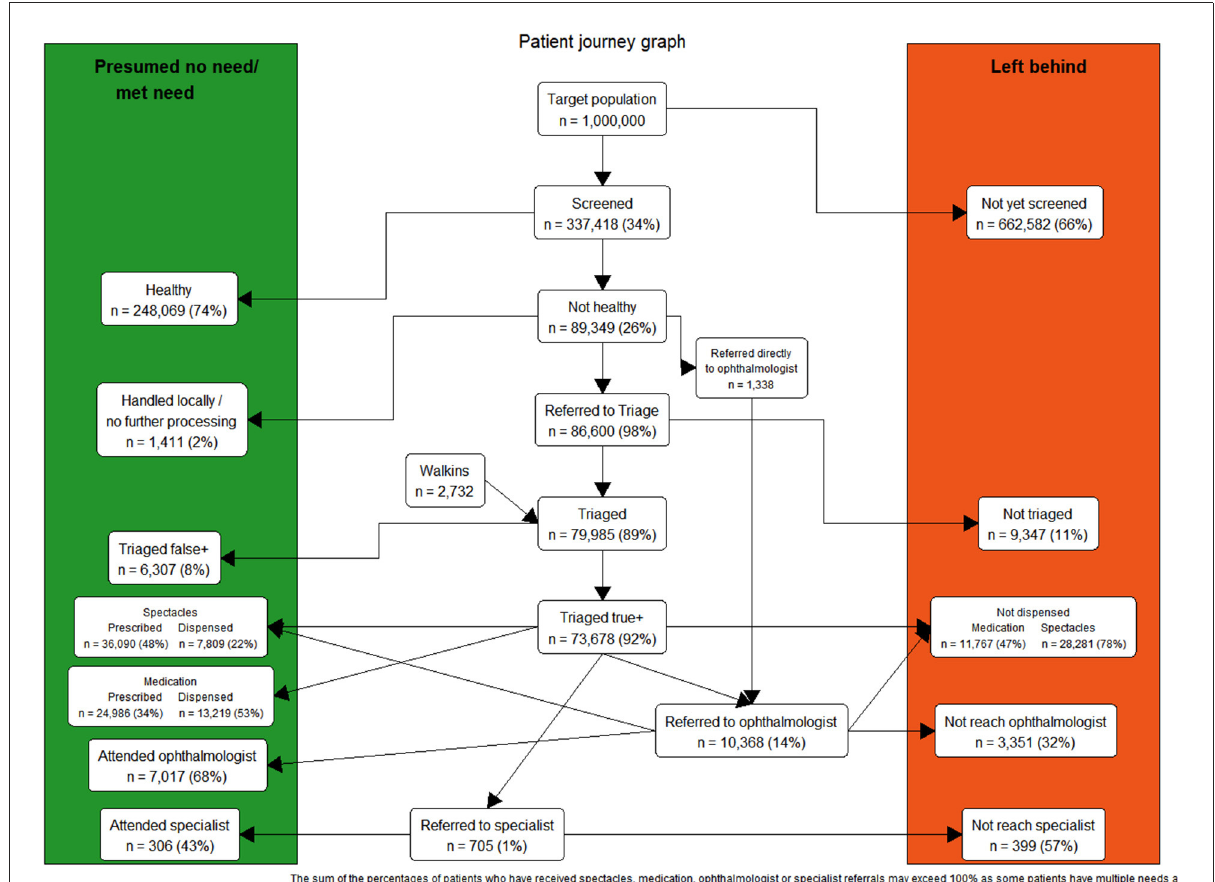
FIGURE3 Patient Journey Graph: Total recruitment to different stages of community and school eye health programmes in Pakistan, November 2018 to September 2021. This figure shows the total recruitment and patient flow in different stages of the programmes. The programme aimed